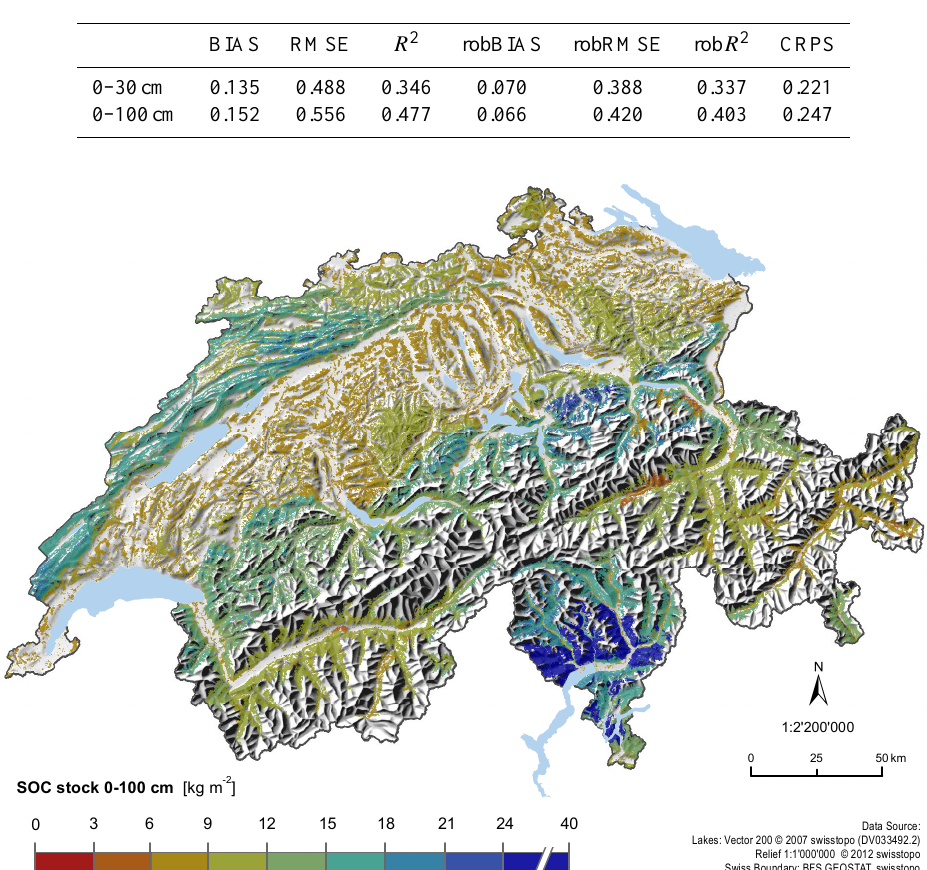
Figure 5. Robust log-normal kriging prediction of the soil organic carbon (SOC) stock in 0–100cm of the mineral soil of Swiss forests (computed with best-fit model with covariates according to Table 1 and tuning constant c = 2, smoothed with focal mean with a radius of 1 pixel =